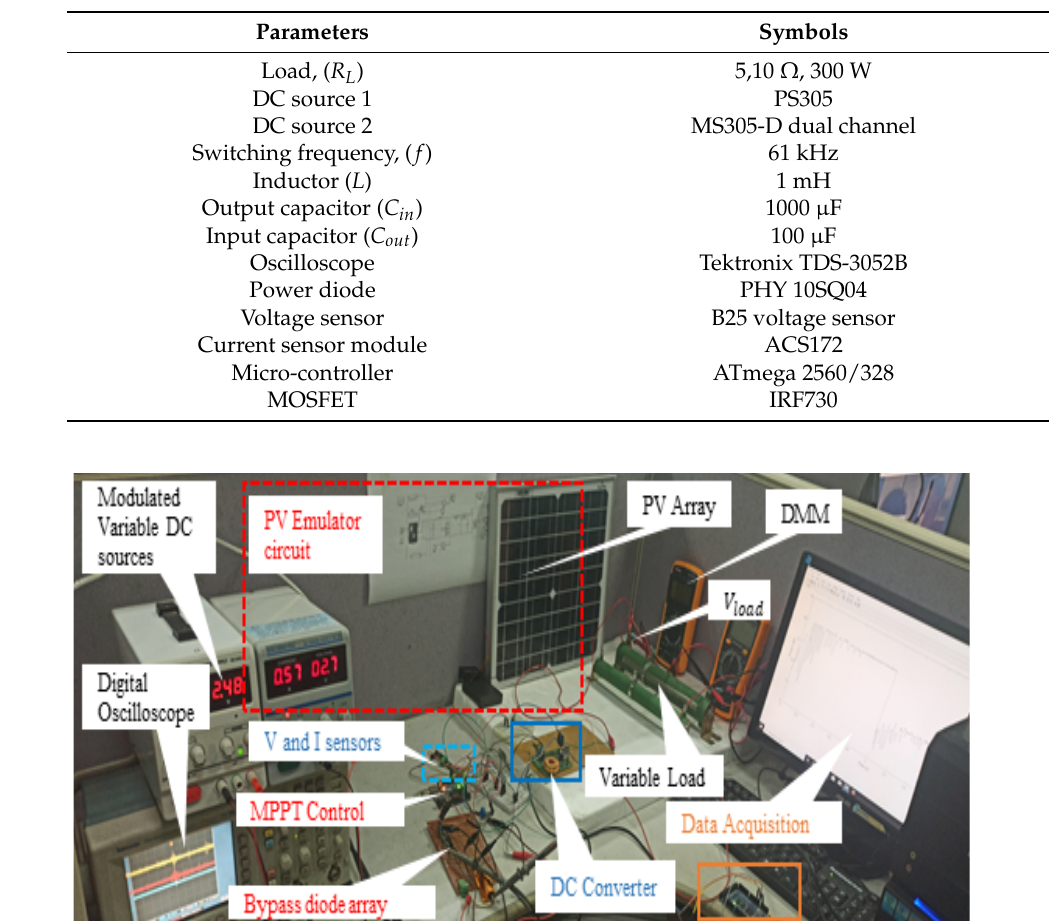
Figure 20. Experimental setup for MPPT. Table 7. Specifications of hardware components.